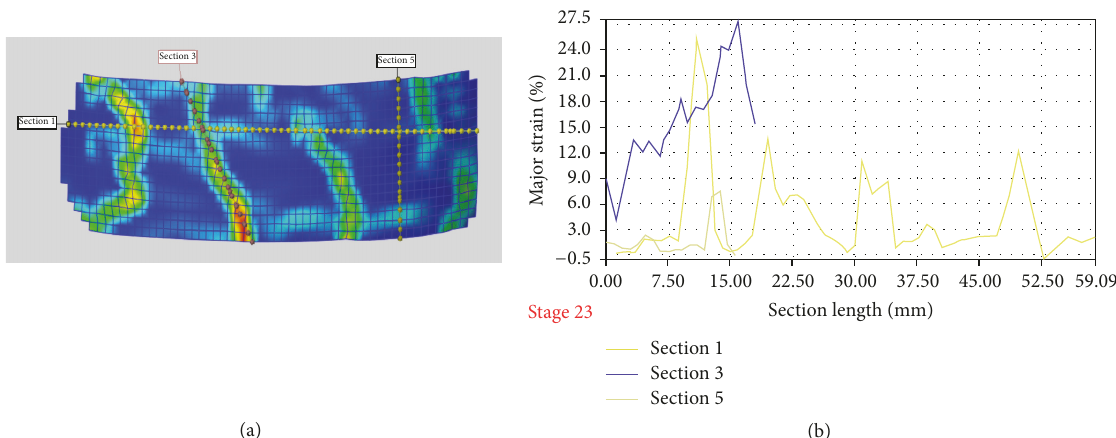
Figure 8: The locations of the three selected sections on the surface of the mudded weak interlayer specimen (a) and the monitoring results of the major strain (b).